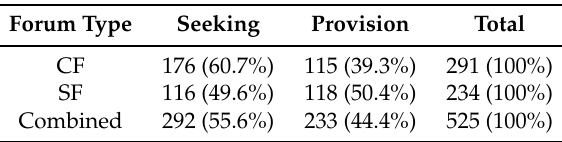
Table 5. Utterances seeking and providing